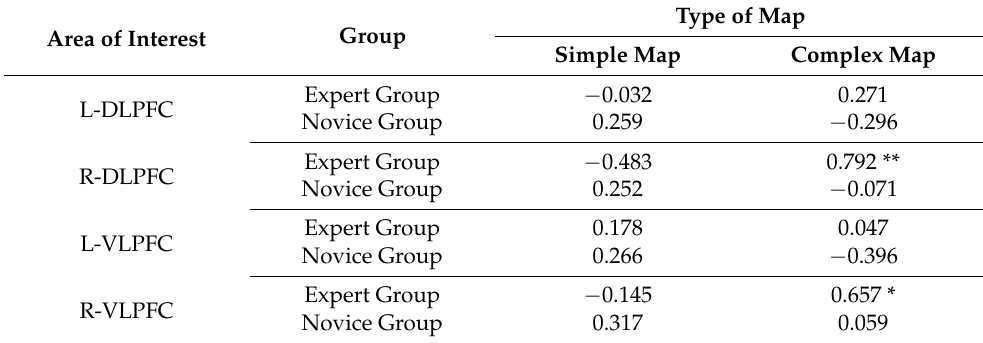
Table 6. Correlation results between fNIRS and behavior (Pearson correlation coefficient r).